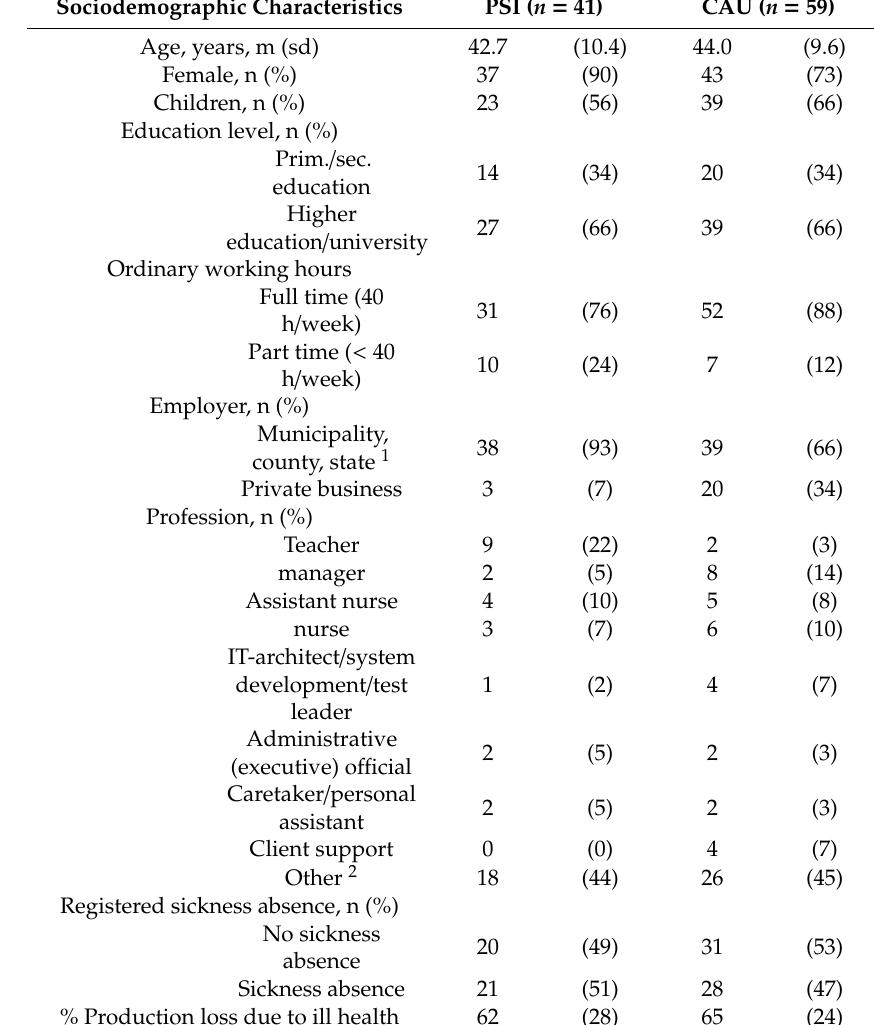
Table 1. Employee Characteristics per Study Group at Baseline.